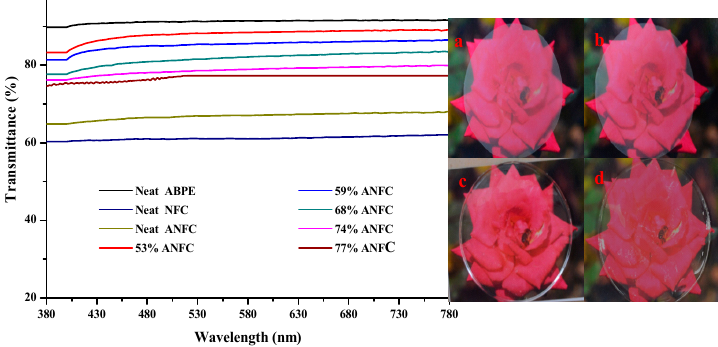
Figure 3. The effects of different ANFC dosages on the transparency of the samples, and the apparent photographs of ( a ) neat NFC film, ( b ) neat ANFC film, ( c ) neat ABPE-10 film, and ( d ) ANFC/ABPE-10 composite film.